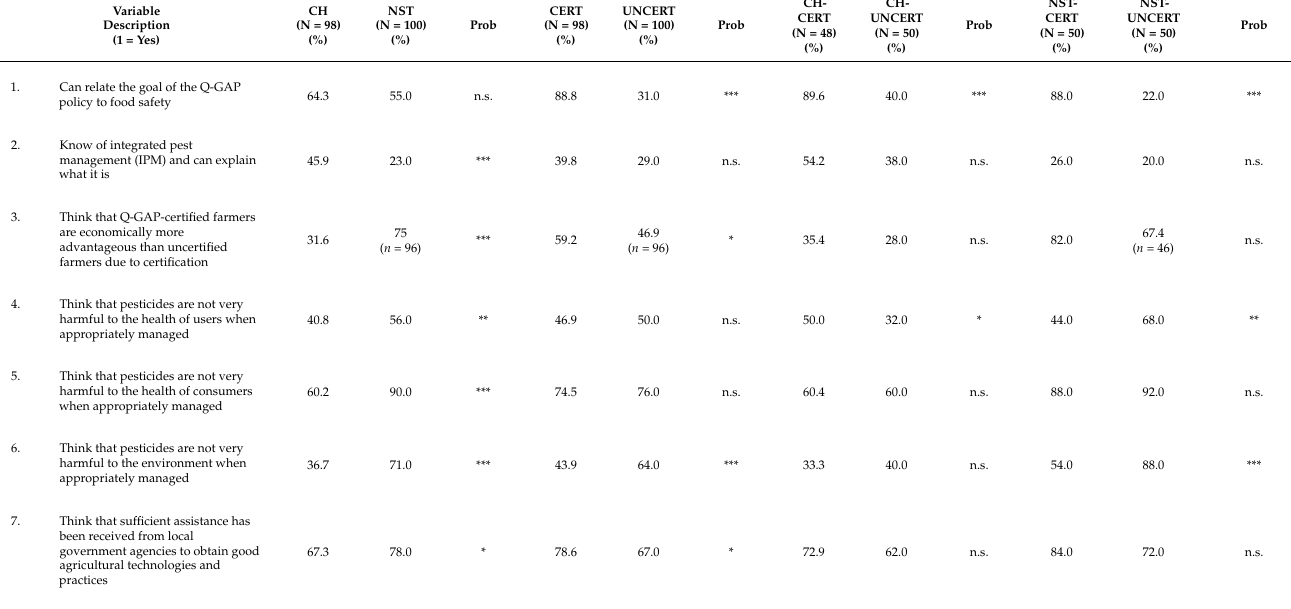
Table 5. Respondent farmers’ perceptions of GAP policy and pesticide